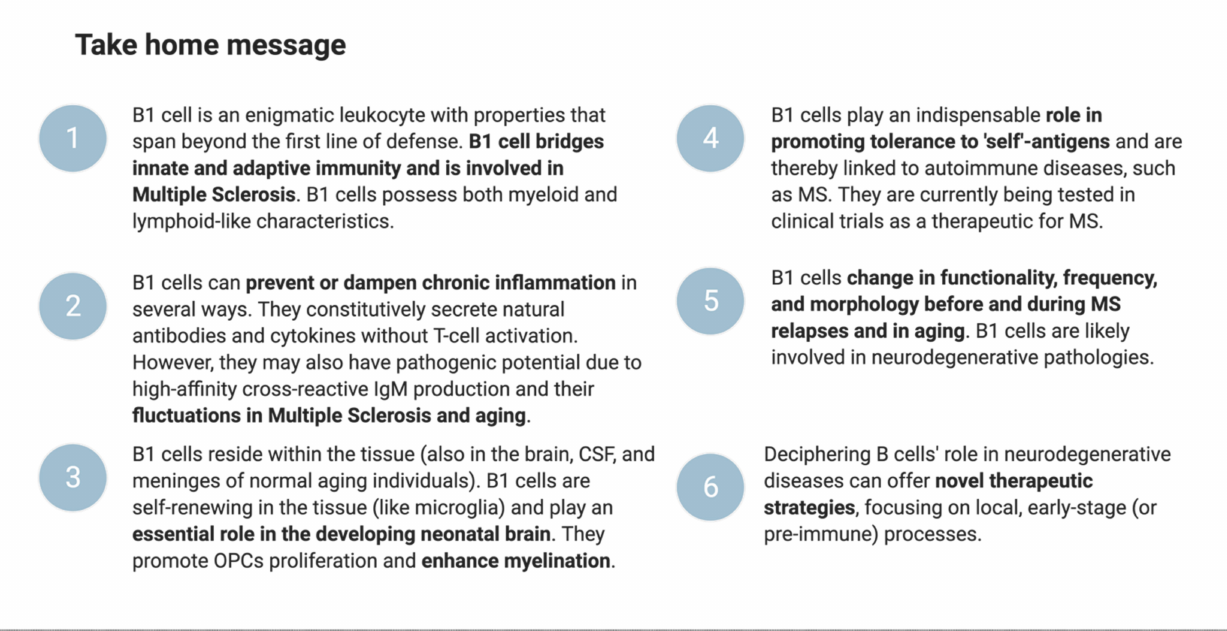
Figure 7. Take home